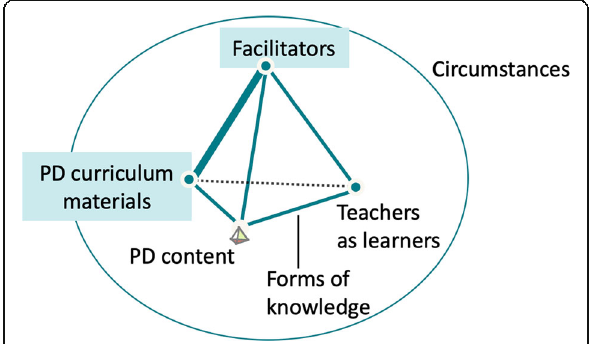
Fig. 4 Areas of teachers ’ categories in and around the PD